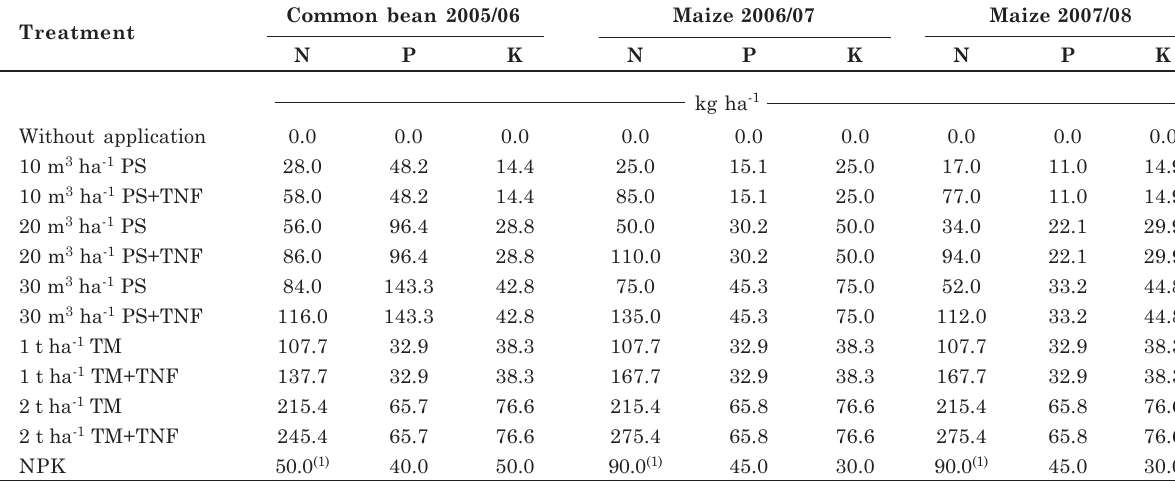
(1) Nitrogen was divided into two applications, one at sowing and the other in topdressing, as recommended by the CQFSRS/SC (2004). Nutrient amounts were applied based on 100 % dry matter.